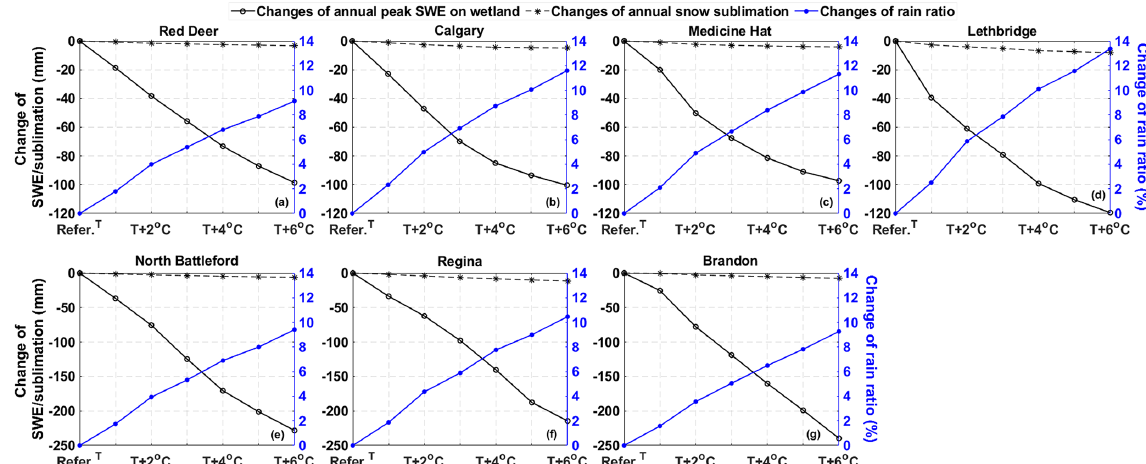
Figure 8. Changes in mean annual peak snow water equivalent (mm) in a wetland HRU, annual blowing snow sublimation (mm) and the change in the mean ratio of rain in annual precipitation (%). Change in rain ratio was calculated by the rain ratio of scenario (%) minus the rain ratio of reference